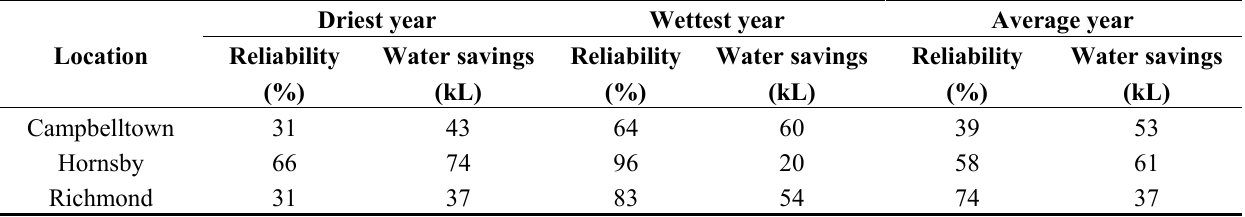
Table 5. Reliability and water savings at Campbelltown, Hornsby and Richmond for a 5 kL rainwater tank for irrigation use for the driest, wettest and average years on record.